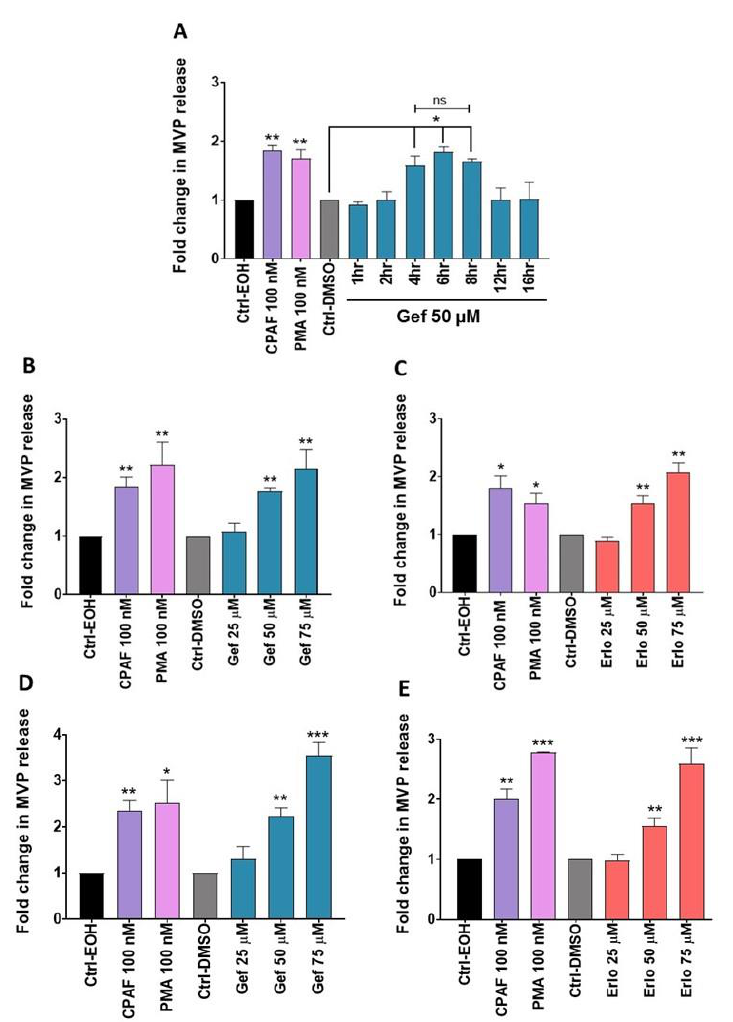
Figure 2. Time and dose-response assessments of gefitinib and erlotinib on microvesicle particles (MVP) release. ( A ) A549 cells were treated with 0.1% EOH or DMSO as vehicle controls, 100 nM CPAF or PMA as positive controls, or 50 µM Gef. After incubation at the given time points, MVPs were isolated and analyzed. ( B , C ) Similarly, A549 cells were treated with vehicle controls, CPAF, PMA, and Gef or Erlo at 25, 50, and 75 µM doses. ( D , E ) Similar experiments as mentioned for A549 cells were performed with H1299 cells. After 4 h of incubation, MVPs were isolated and analyzed. Data are representative of mean ± SE of three independent experiments, normalized per 1 × 10 6 cells. Statistically significant differences were observed between Ctrl-EOH and CPAF or PMA (* = p < 0.05, ** = p < 0.01); Ctrl-DMSO and Gef or Erlo at various doses (* = p < 0.05, ** = p < 0.01, *** = p < 0.001); ns denotes non-significant changes between the analyzed groups.